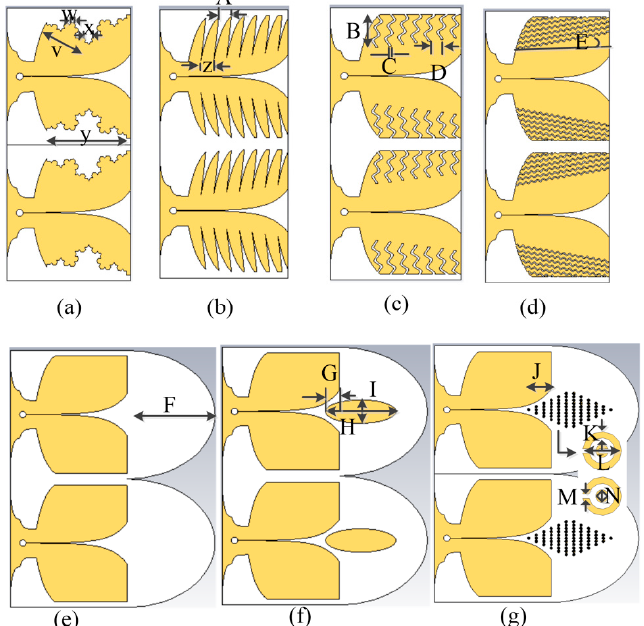
Figure 2. The 1 × 2 MIMO Coplanar Vivaldi Antenna of ( a ) Koch Fractal Structure Palm Tree (KFSPT ‐ CVA), ( b ) Exponential Slot Edge Palm Tree (ESEPT ‐ CVA), ( c ) Vertical Wave Structure Palm Tree (VWPT ‐ CVA), ( d ) Horizontale Wave Structure Palm Tree (HWPT ‐ CVA), ( e ) Regular Lens Palm Tree (RLPT ‐ CVA), ( f ) Elips Lens Palm Tree (ELPT ‐ CVA), ( g ) Metamaterial Lens Palm Tree (MLPT ‐ CVA), and ( h ) bottom view. Table 1. Parameter dimension of the antenna . Dimension (mm)